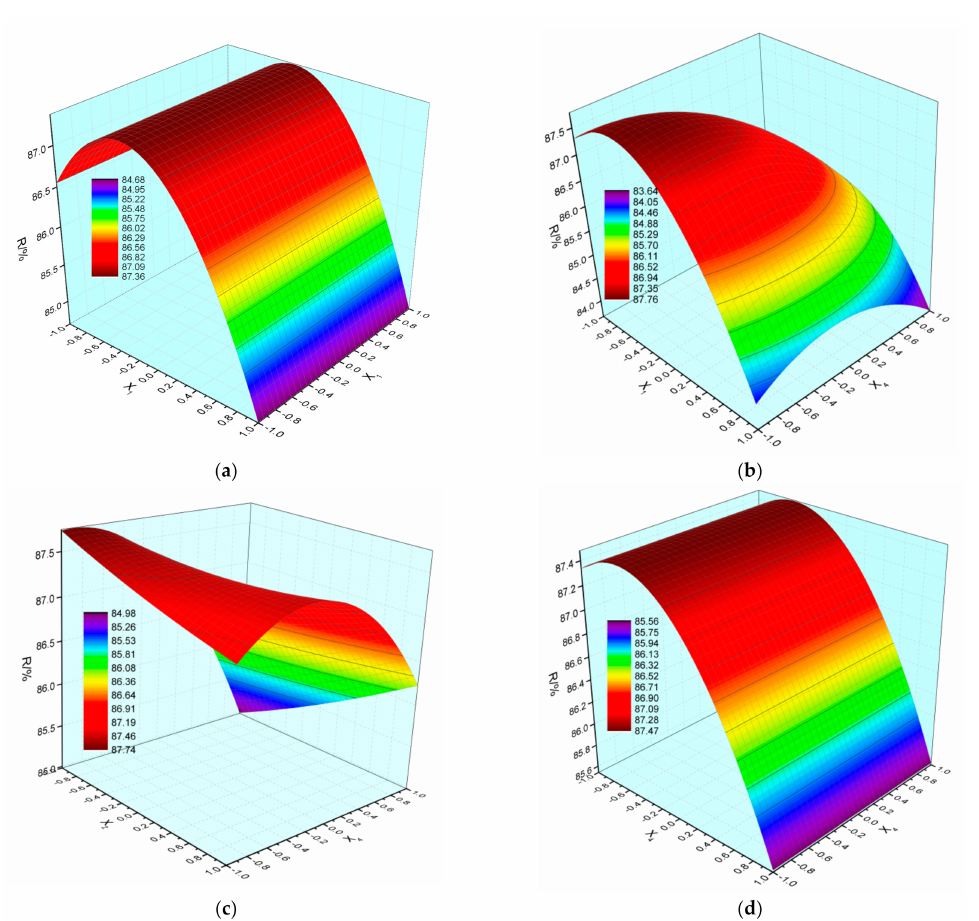
Figure 8. Interactions between factors by RSM. ( a ) X 12 , ( b ) X 1 X 4 , ( c ) X 2 X 4 , ( d ) X 42